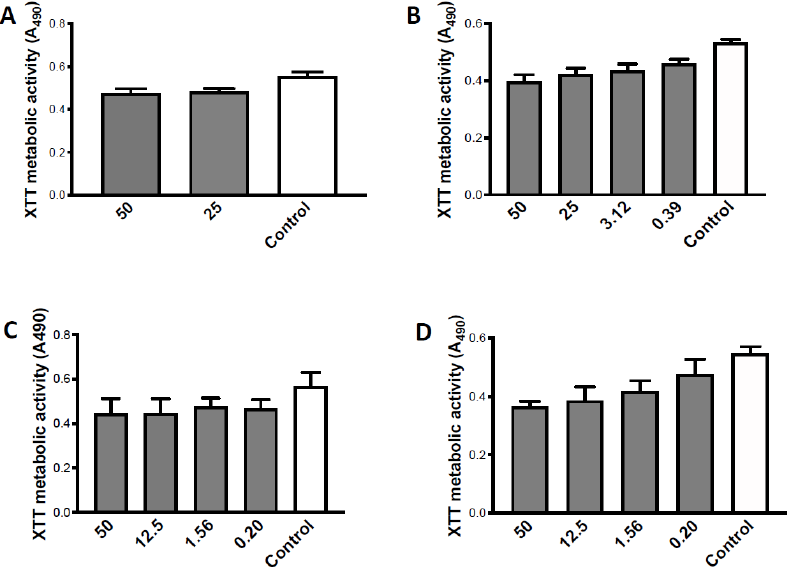
Figure 4. Studies of alkyl side chains on PQS. Dose-response assays. ( A – D ) are C1-PQS, C3-PQS, C5-PQS, C9-PQS respectively, tested against preformed 10AF biofilm, DMSO control shown. ( A ) Twofold dilutions C1-PQS 50 to 0.2 μg/mL were made. Dilutions 12.5 to 0.2 μg/mL produced slight and insignificant ( p > 0.05) inhibition compared to control, and not different from each other (not shown). Only at 25 and 50 μg/mL was inhibition significant, and only at p < 0.05. ( B ) Same plan as in A, C3-PQS; 0.2 μg/mL produced slight and insignificant ( p > 0.05) inhibition, and 0.39 to 50 μg/mL were all inhibitory compared to control ( p < 0.01) and not significantly different from each other in effect. ( C ) Same plan as in A, C5-PQS. All dilutions were inhibitory ( p < 0.05) compared to control, but were not different from each other. ( D ) Same plan as in A, C9-PQS. Slight dose-response, as shown. All dilutions were inhibitory compared to controls, but were not significantly different from each other; 0.2 to 0.78 μg/mL were p < 0.05 compared to controls, and 1.56 to 50 μg/mL were p < 0.001 compared to controls.